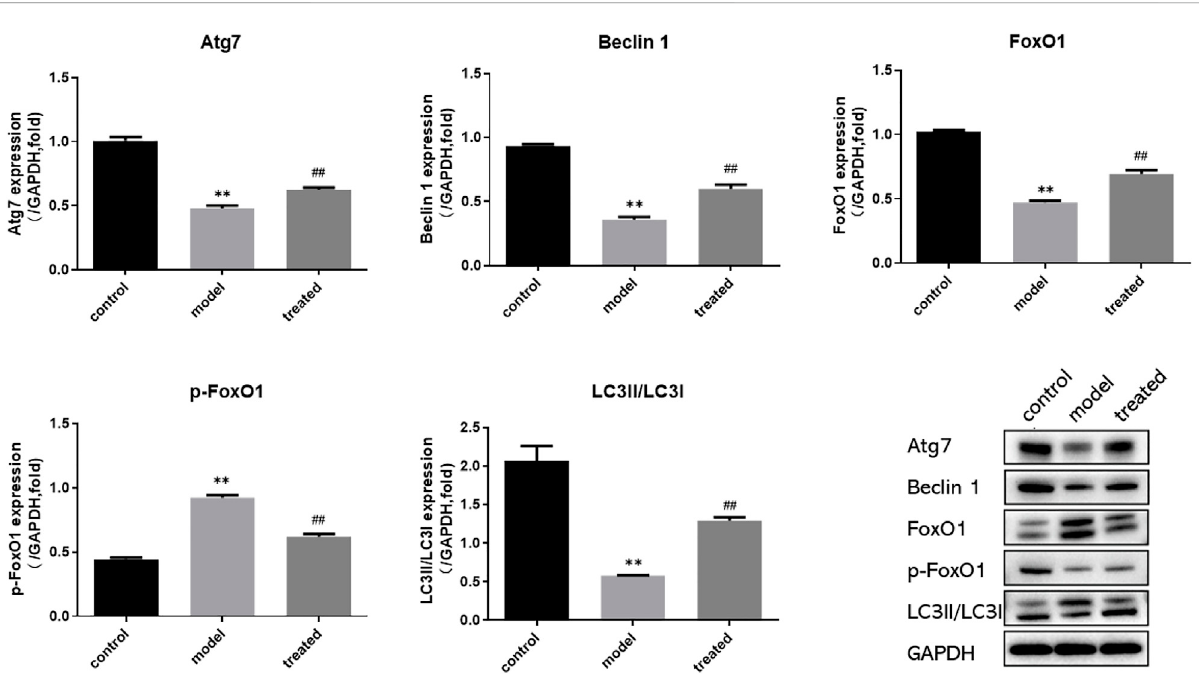
FIGURE 12 Western blot analysis of Atg7, FoxO1, p-FoxO1, Beclin1, LC3 and GAPDH protein expression in the heart. ** p < 0.01 vs. control group; ## p < 0.01 vs. model